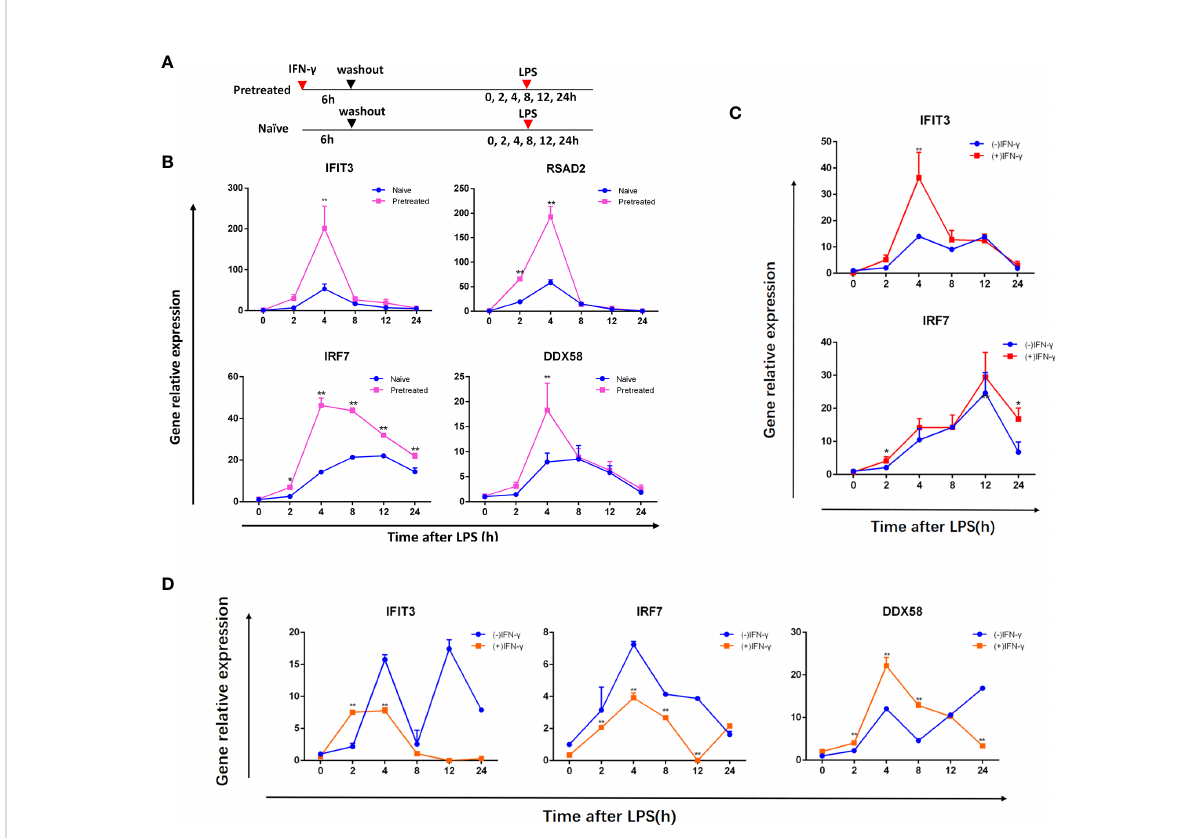
FIGURE 1 IFN stimulation produces memory in BMDMs from ICR mice and MRL/lpr lupus mice. (A) Treatment of cells. First, the naive and pretreated BMDMs were cultured for 24 hours lacking IFN after being treated with medium or 100 units/ml IFN over 6 hours, respectively. LPS (1ug/ml) was then added to these BMDMs and incubated for the given duration (in hours). qRT-PCR was used to assess ISG mRNA in BMDMs from 10-12 week old female MRL/lpr mice (B) , female ICR mice (C) , 16-18 week old female MRL/lpr mice (D) , which was normalized to Gapdh and represented as fold induction. (-) IFN- g group was naive cells, (+) IFN- g group was pretreated cells. Instances of memory ISGs are IFIT3, DDX58, IRF7 and RSAD2. The data represent the mean of three independent experiments ± SD. Statistically signi fi cant differences are indicated (Student ’ s t test, *P < 0.05, **P <